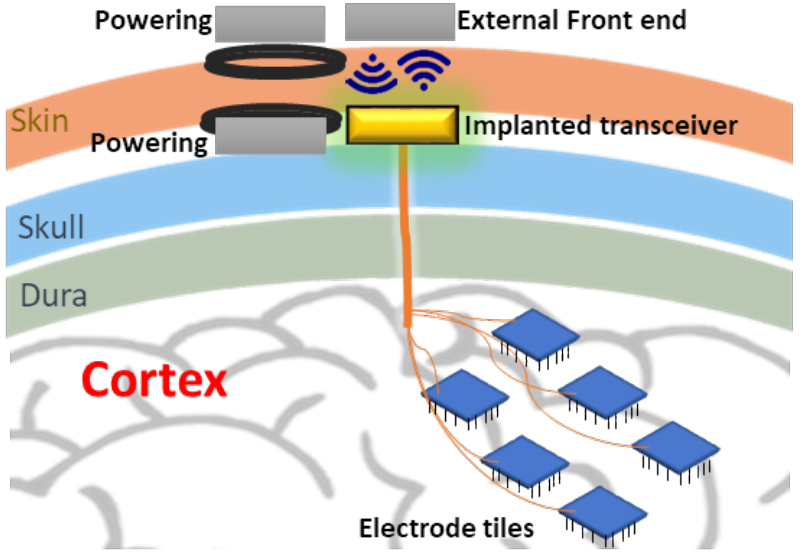
Figure 1. System layout of the wireless enabled visual prosthesis. Note: The transmitter and receiver, without the coil/antenna, is covered in this